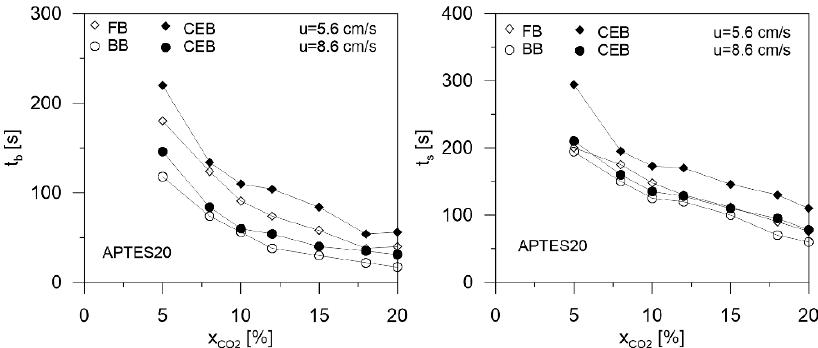
Figure 17. Breakpoint and saturation times at increasing CO 2 concentrations for APTES20 at different contact modes and at two velocities. Table 6. Characteristic parameters of the adsorption tests on APTES20 for different values of gas velocity, for different layouts, and at varying inlet gas concentrations of CO 2 . (* FB: fixed bed; BB: bubbling bed; CEB: confined expanded bed) .